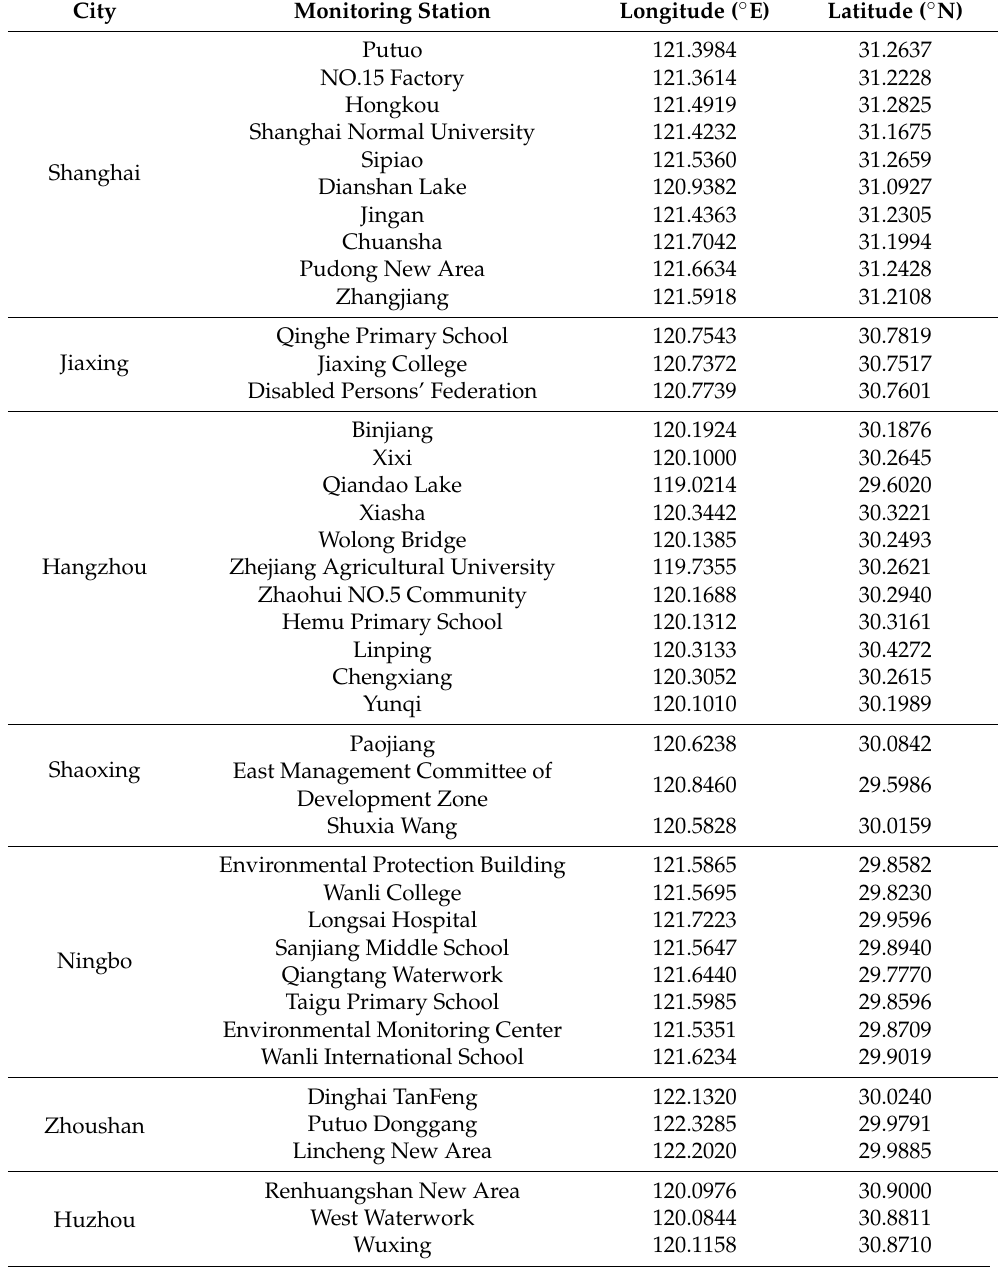
Table 2. Geographical coordinates of PM 2.5 monitoring stations in